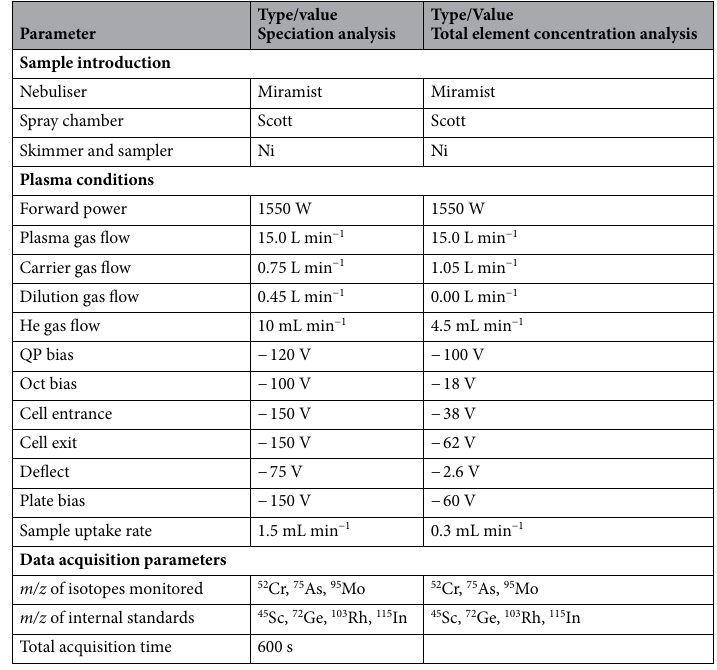
Table 1. ICP-MS operating parameters.